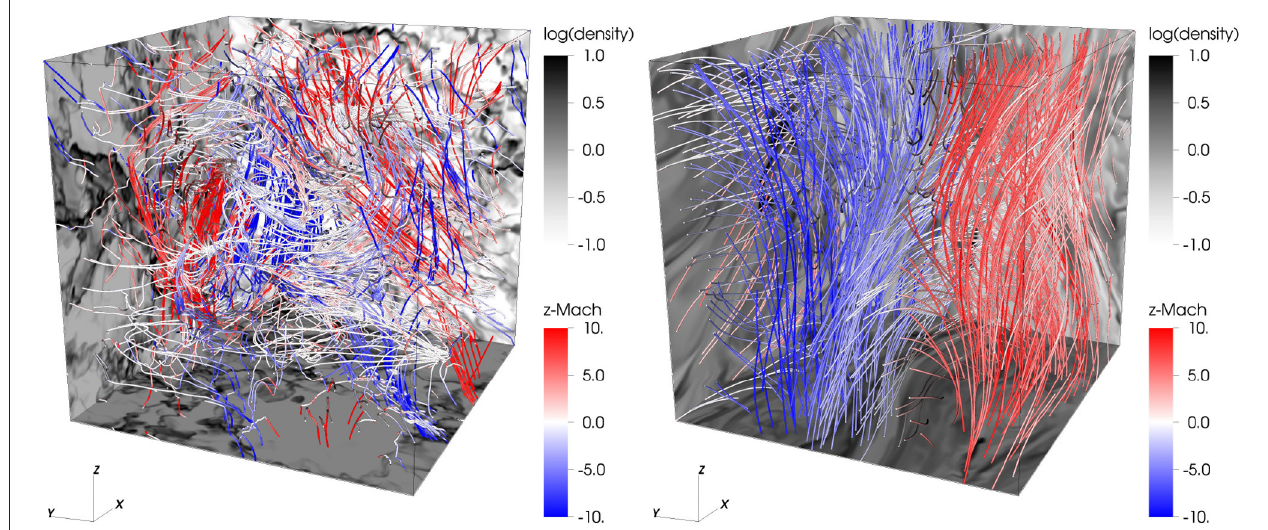
FIGURE 2 | Results from two simulations of compressing isothermal turbulence, without (left) and with (right) a magnetic field, from Birnboim et al. (2018). In both panels, lines show flow streamlines, with the z -velocity along the streamline color-coded by Mach number. Grayscale on the box edges indicates the logarithm of gas density, in units where the mean density in the computational domain is unity. The total velocity dispersions in the two simulations shown are comparable, but the simulation including a magnetic field has a much lower dissipation rate because the field has organized the flow into a highly-anisotropic